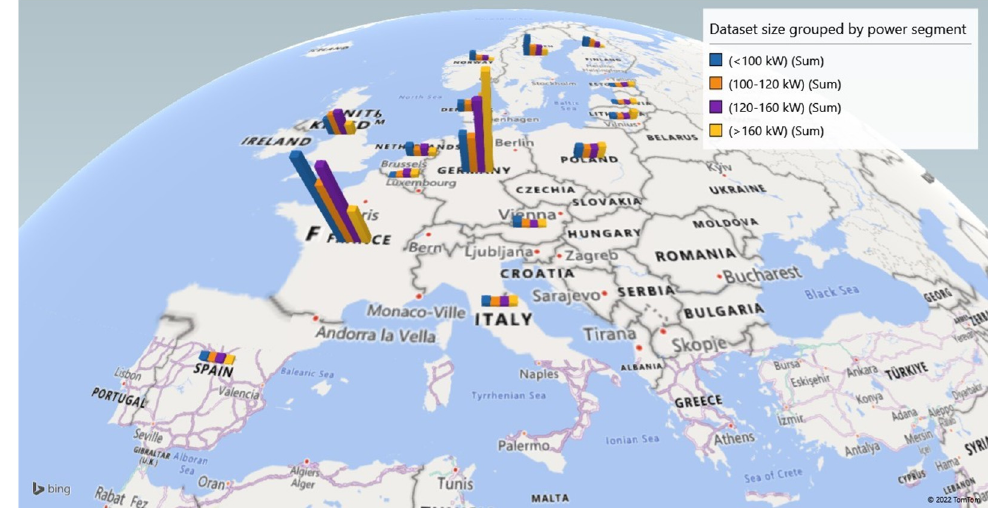
Figure 3. Dataset size grouped by country and power segment.